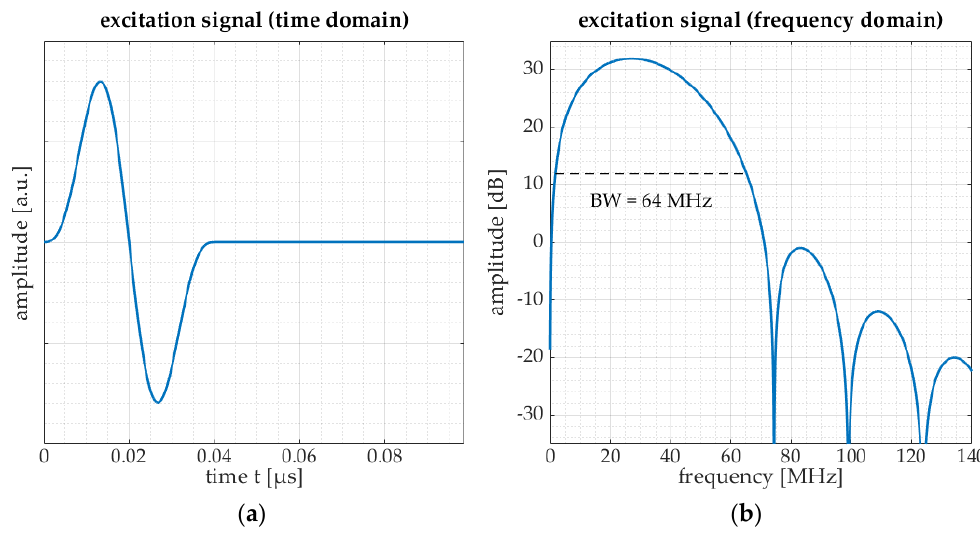
Figure 6. ( a ) The excitation signal ( a ) in the time domain; and ( b ) in the frequency domain. The dashed line denotes the bandwidth at − 20 dB.